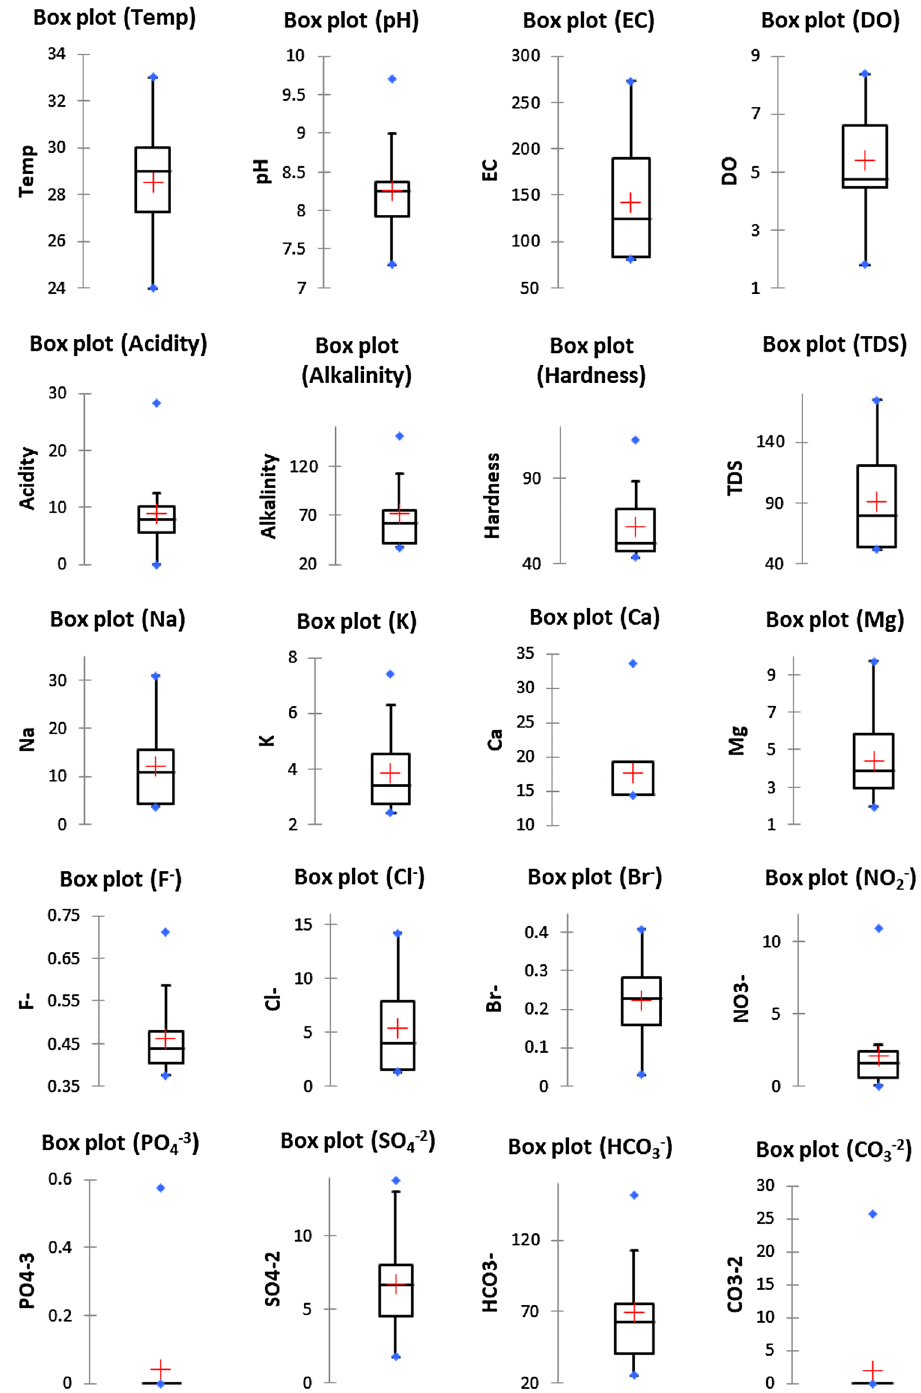
Fig. 4 Box plot variables of pre- monsoon